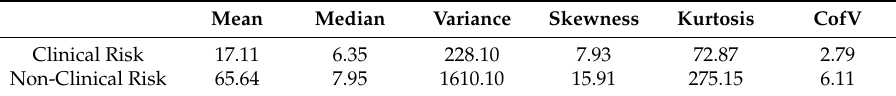
Table 2. Descriptive statistics of severity.